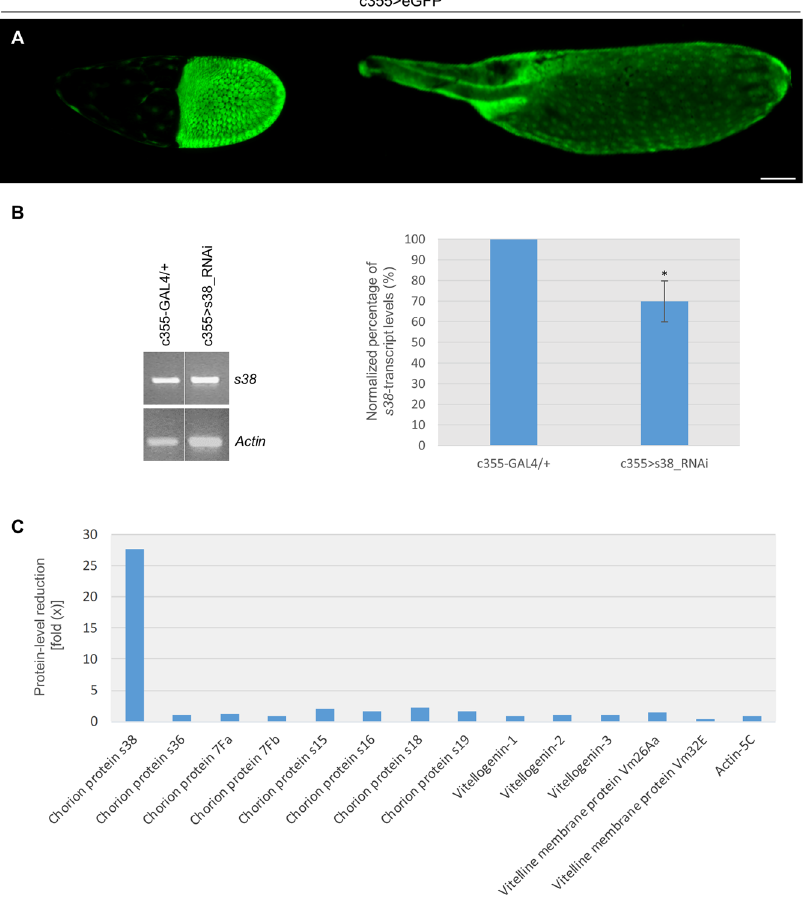
Figure 1. RNAi-mediated targeting of s38 gene specifically in the follicle-cell population of D. melanogaster generates ovaries with severely reduced levels of s38 protein. ( A ) Confocal laser scanning microscopy (CLSM) images of representative stage-10 (left panel) and stage-14 (right panel) follicles derived from c355 > eGFP transgenic control flies, specifically expressing the eGFP reporter protein in their follicle cells. Number of follicles examined: 89. ( B ) The s38 -transcript contents in s38-targeted (c355 > s38_RNAi) ovaries are presented with an -average- reduction of 30%, as compared to control (c355-GAL4/ + ) ones, via employment of an RT-PCR protocol and utilization of Actin as gene of reference. ( C ) Graphical presentation of Mascot score- based comparative measurements of relative protein abundance (presented in fold: “x”), in between s38- downregulated (Table S2) and control 38 ovaries. Scale Bar: 50 μ m. * p <